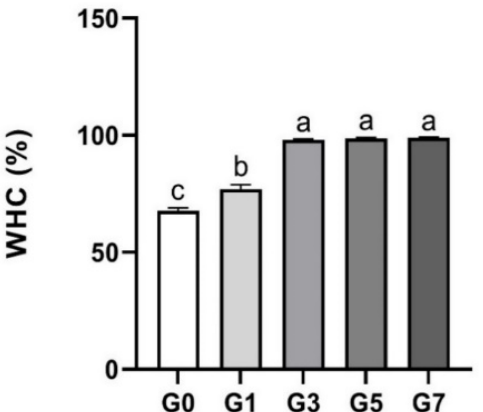
Figure 2. Water holding capacity of abalone 3D print ink at various concentrations of gelatin (0–7%). Error bars represent the standard deviation, and different letters on the top of the column indicated a significant difference ( p < 0.05).